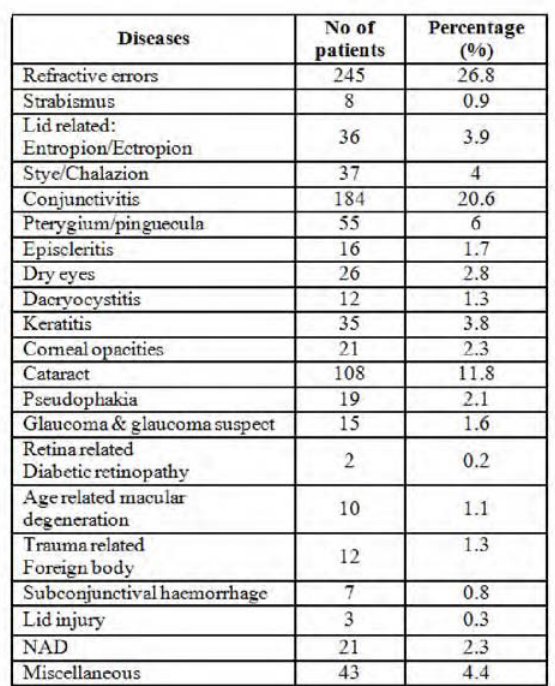
Table-2: Pattern of ocular